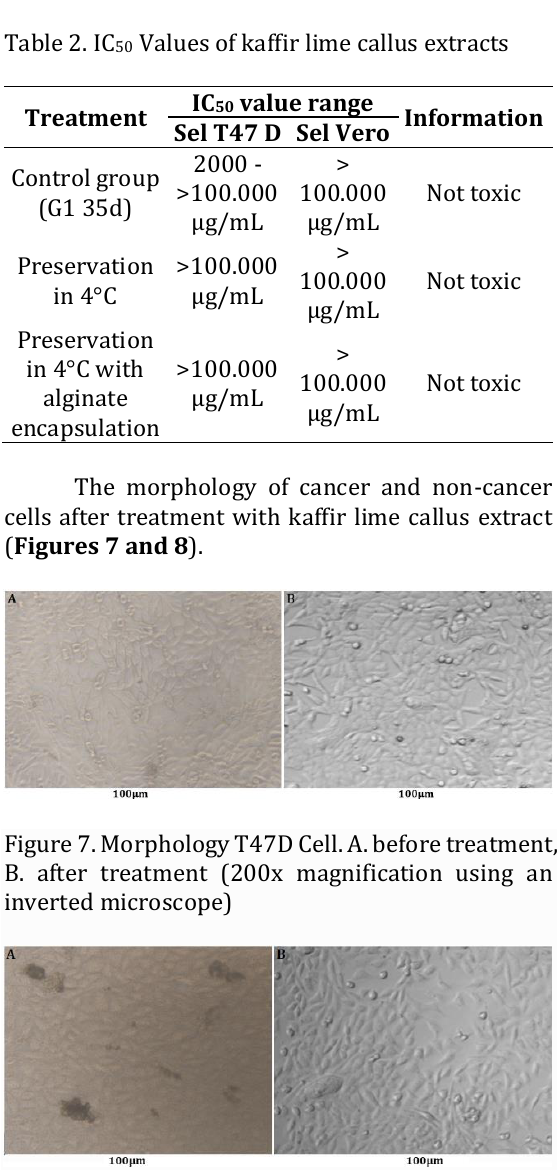
Figure 8. Morphology Vero Cell. A. before